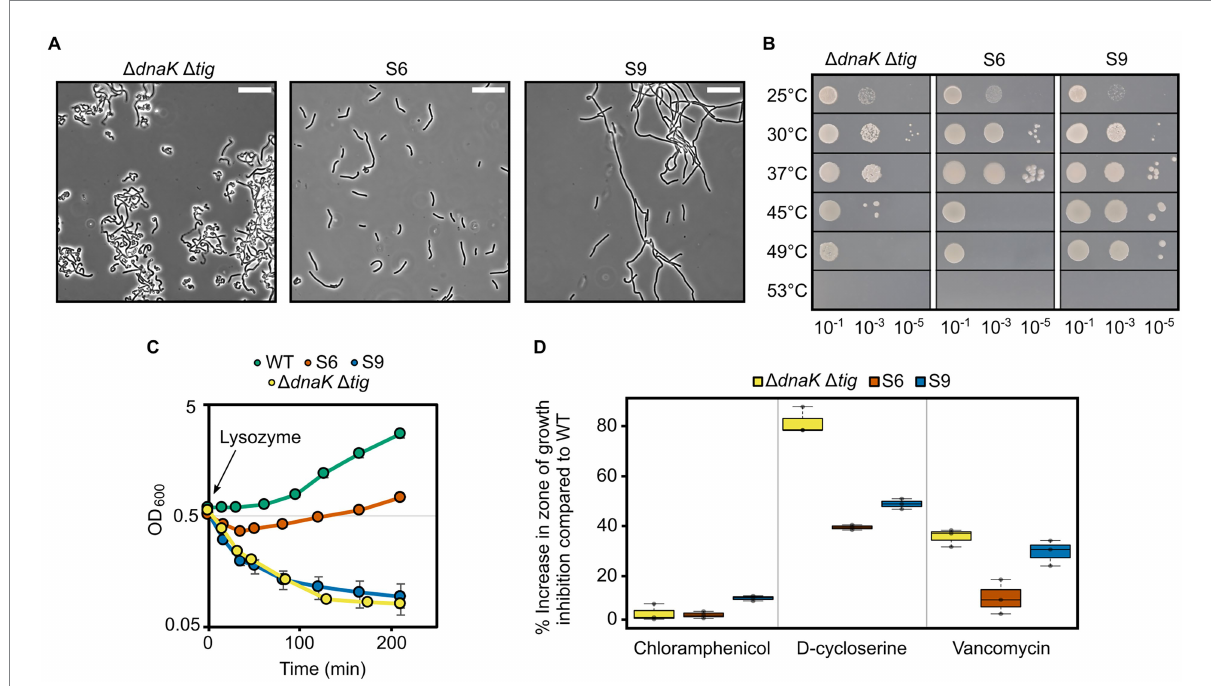
FIGURE 8 Properties of two selected suppressors with a partially restored morphology. (A) Phase contrast micrographs of B. subtilis Δ dnaK Δ tig (LUW878) and the LUW878 suppressors S6 and S9. Cells were taken from single colonies from overnight TBAB plates incubated at 30 ° C. The scale bar represents 20 μ m. (B) Spot dilution assay for the indicated strains at different temperatures. Serial dilutions were spotted on TBAB plates. 10 − 7 dilution was also spotted but not shown, since none of the strains grew. Plates were incubated at the indicated temperatures for 24 h. (C) Cell density measured by OD at 600 nm of the indicated strains after the addition of 15 μ g/ml lysozyme at OD 600 = 0.6 ( t = 0). Strains were grown in NSMPG at 30 ° C. Each strain was grown in triplicates, and error bars represent the standard deviation between them. Error bars might not be seen due to the small variation. (D) Sensitivity of the indicated strains to chloramphenicol (protein synthesis inhibitor), D-cycloserine and vancomycin (antibiotics that target the cell wall). Plotted is the increase in percentage in the zone of growth inhibition when compared to the wild-type strain. Plates with the antibiotic discs were incubated at 30 ° C for 20 h. Three antibiotic discs were used for each strain, and error bars display the standard deviation between the